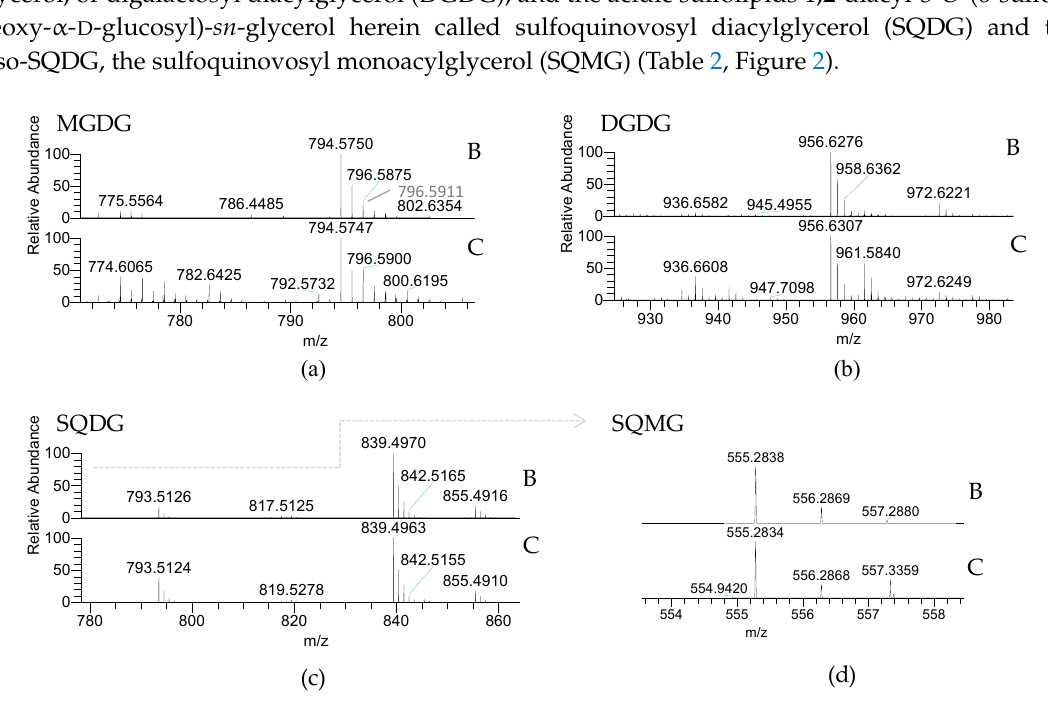
Figure 2. LC–MS of glycolipids from Porphyra dioica blade (B) and conchocelis (C) detected using HILIC–MS: ( a ) Monogalactosyl diacylglycerol (MGDG) and ( b ) Digalactosyl diacylglycerol (DGDG) molecular species were identified as [M + NH 4 ] + ions; ( c ) Sulfoquinovosyl monoacylglycerol (SQDG) and ( d ) Sulfoquinovosyl monoacylglycerol (SQMG) were identified as [M − H] −